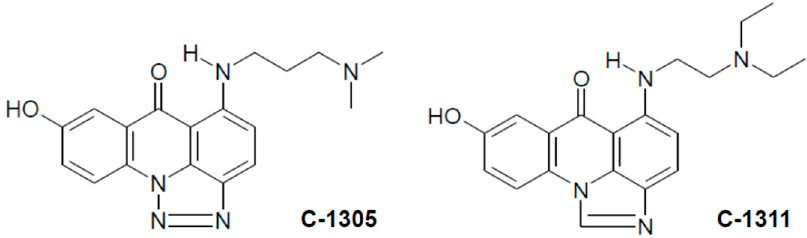
Figure 1. Chemical structures of studied compounds, triazoloacridinone (C-1305) and imidazoacridinone (C-1311).